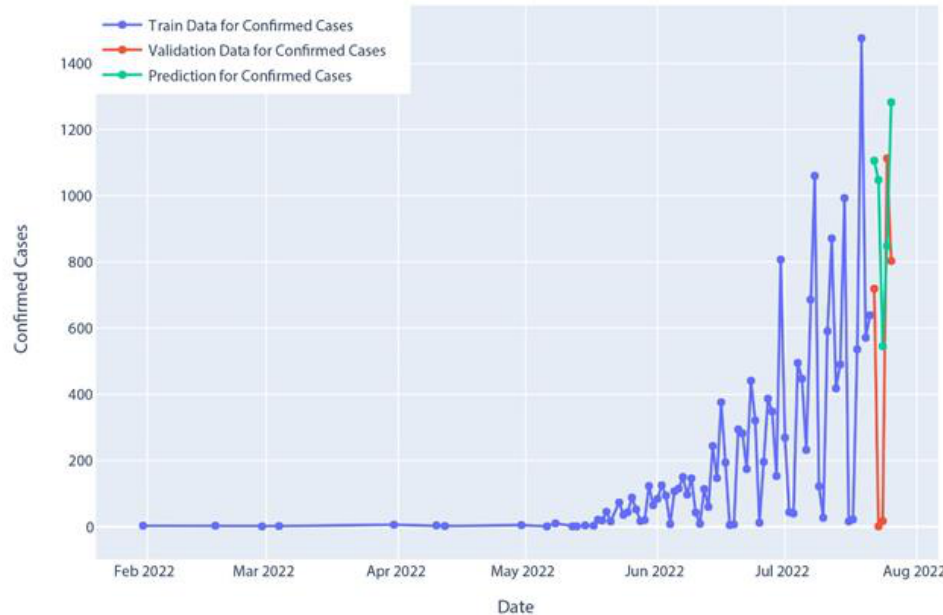
Figure 21. Confirmed cases of ARIMA model prediction.